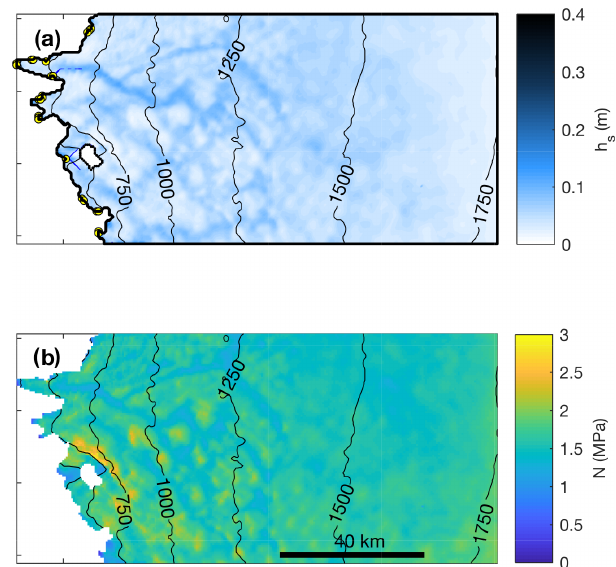
Figure 7. Modelled state of the subglacial hydrology system at the end of the winter. (a) Map of sheet thickness, with black contours showing surface elevation. (b) Map of effective pressure overlaid with surface elevation